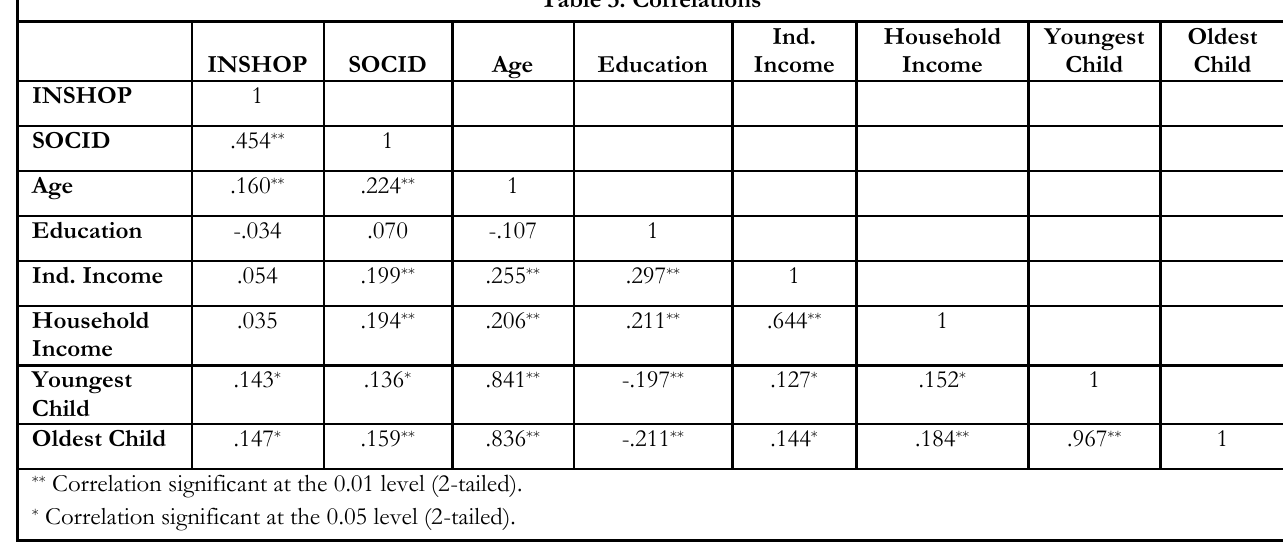
Table 3: Correlations